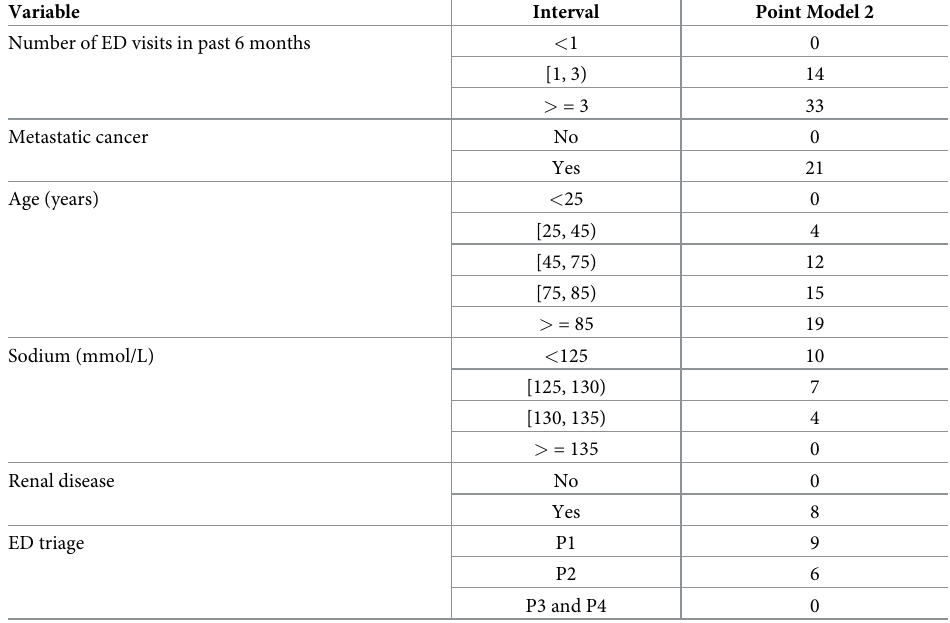
Table 4. Scoring table of Model 2 generated using AutoScore, with variables ranked by ShapleyVIC.